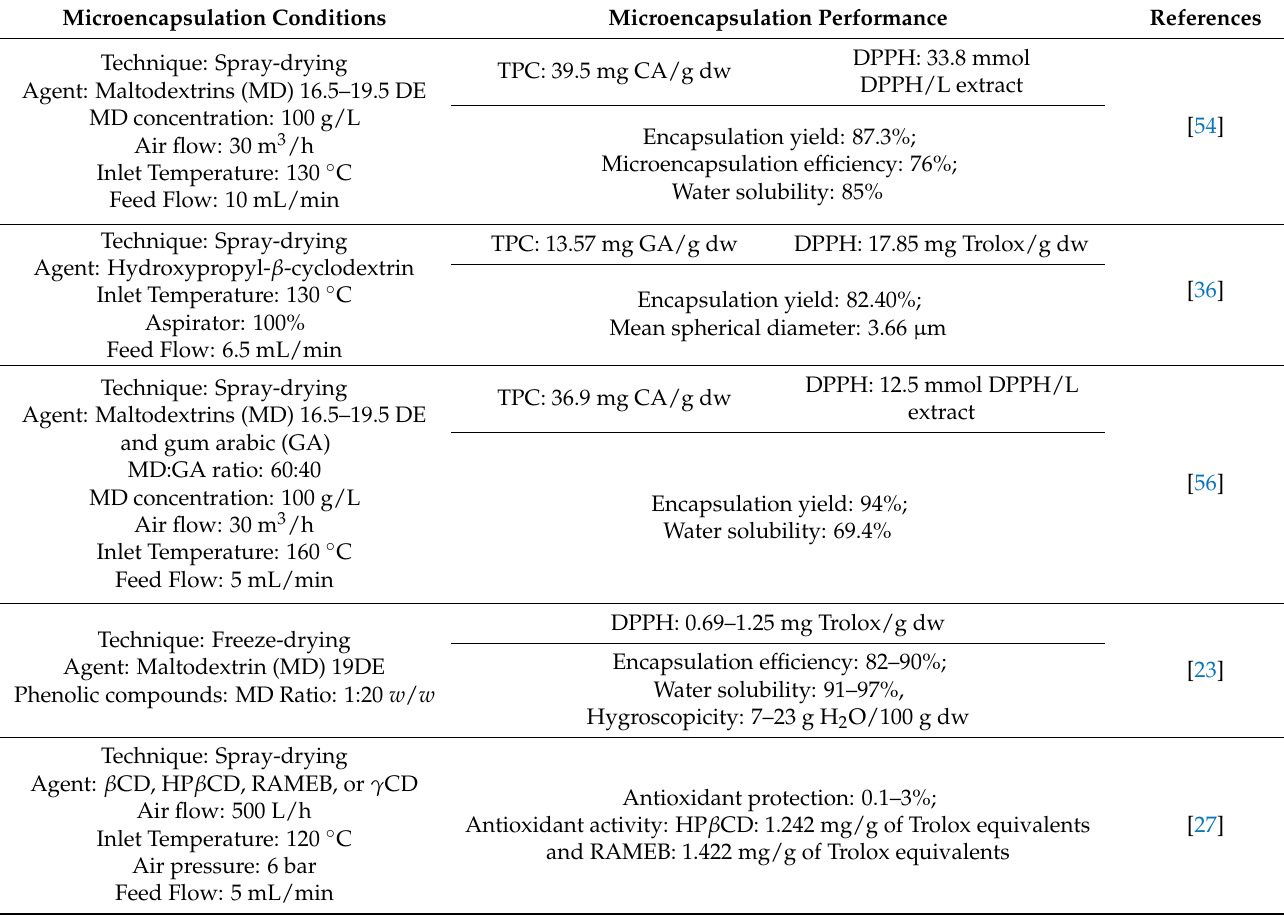
Table 3. Microencapsulation of phenolic compounds from olive